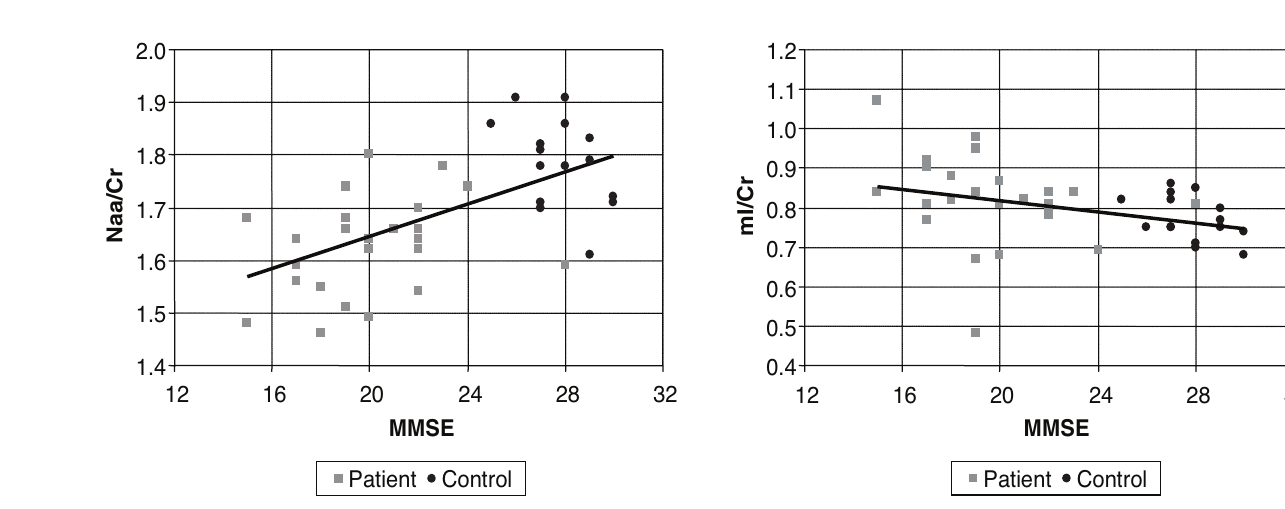
Figure 3. Scatter plot for MMSE and Naa/Cr in the cingulated. Naa/Cr, N-acetil-asparte/creatine ratio.